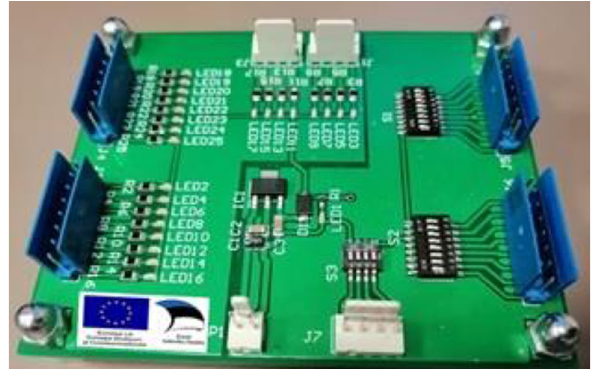
Figure 6. Logic test bench